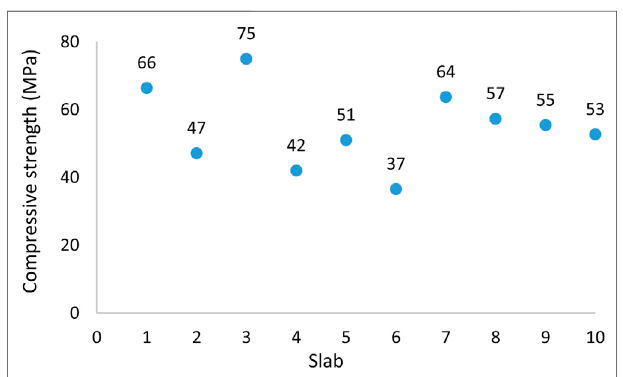
FIGURE 2 | Compressive strength of cored samples from parent concrete